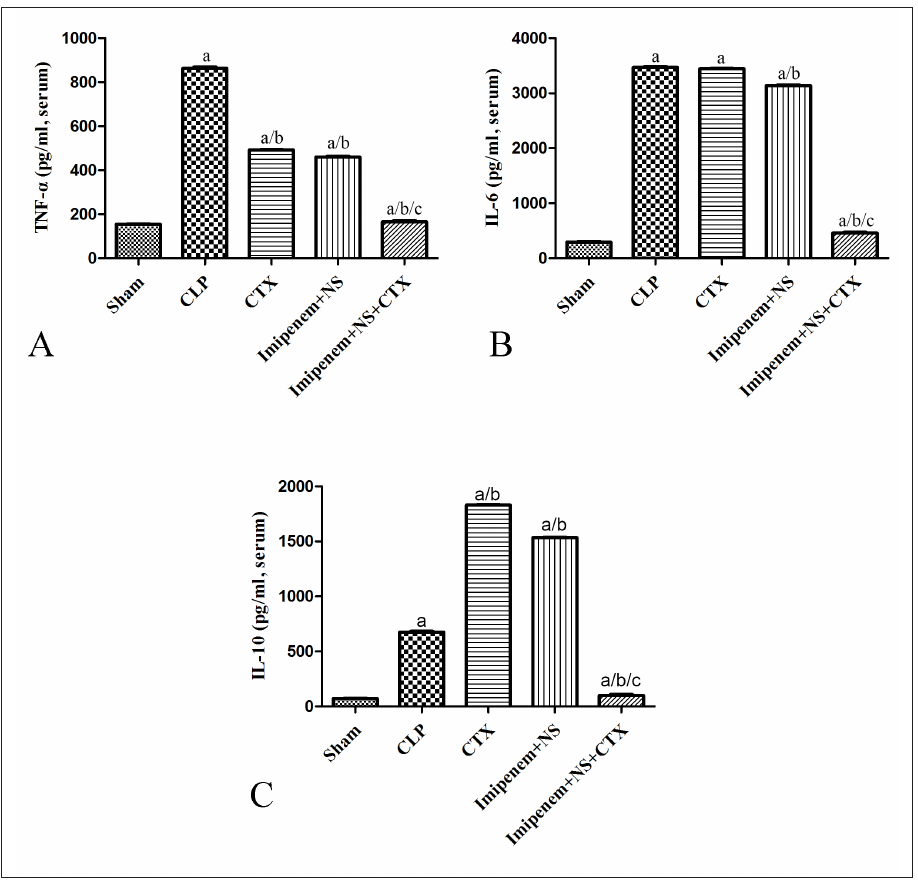
Fig. 2. Measurement of the serum levels of cytokines TNF-α (A), IL-6 (B) and IL-10 (C). The levels are expressed as mean ± SD with significant threshold P <0.05. Compared to the sham group, there was statistically significant difference ( P <0.05); Compared to the CLP group, there was statistically significant difference ( P <0.05); Compared the imipenem+NS group with the imipenem+NS+CTX group, there was statistically significant difference ( P